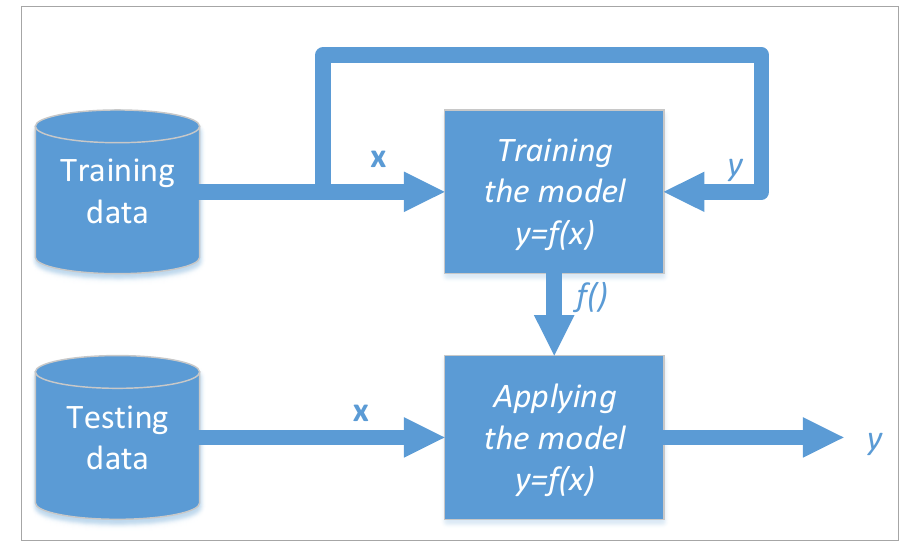
Fig. 2. Process of supervised machine learning